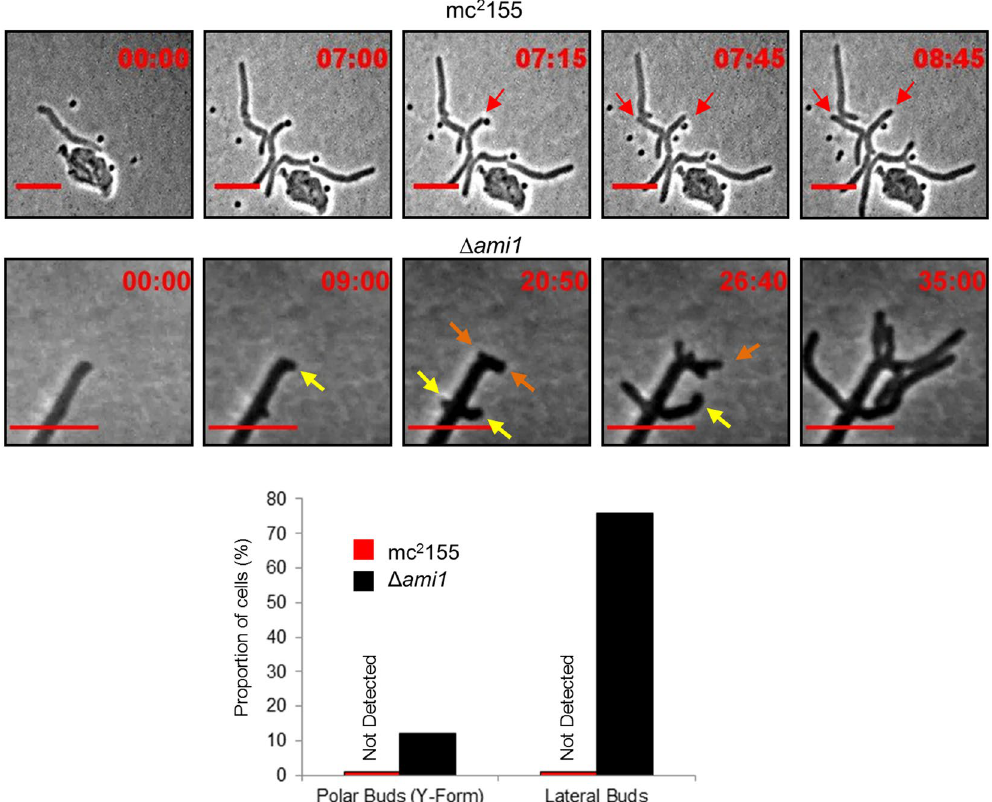
Figure 2. ( A ) Time-lapse microscopic analysis of growth in the Δ ami1 mutant strain. Cells were grown and imaged in Middlebrook 7H9 media. Shown is the growth of mc 2 155 (top panel), which displays a growth and cell division pattern that is typical of mycobacteria with polar extension of cells (red arrows), as well as the Δ ami1 strain, which exhibited the formation of lateral buds (yellow arrows) that subsequently formed branches. Scale = 5 µ m. Ectopic polar growth and Y-formed cell division was also noted (orange arrows). Time frame is in hours. The histogram depicts the proportion of microcolonies with polar/lateral budding. For the Δ ami1 mutant and wild type, 74 and 59 micro-colonies were